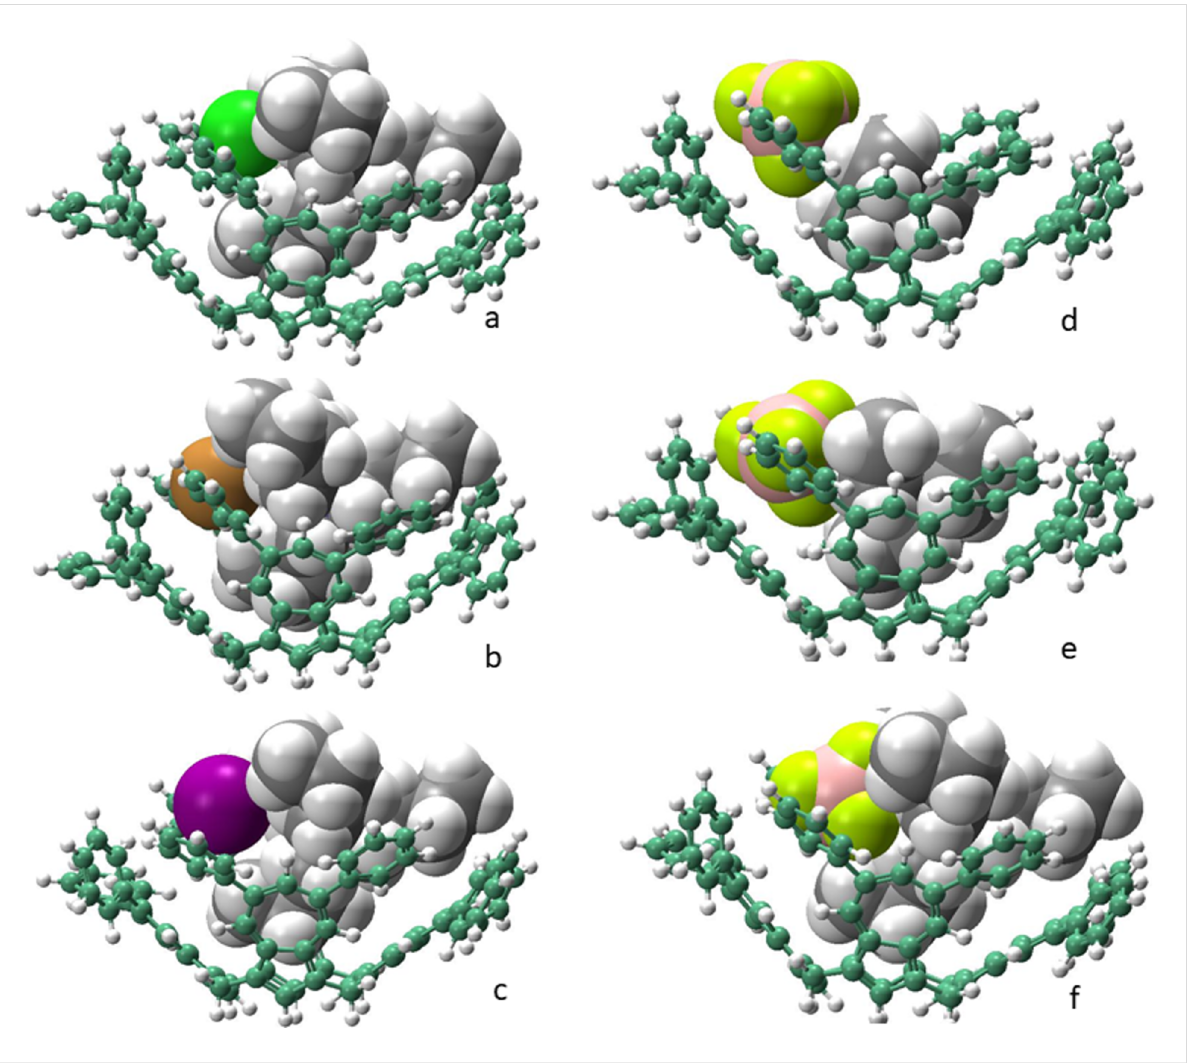
Figure 3: Geometry-optimized ( ω B97xD/6-31G(d)) and ( ω B97xD/GenECP) structures, respectively, computed for left: (a) 5 TBACl; (b) 5 TBABr; and (c) 5 TBAI; right: (d) 5 TMABF 4 ; (e) 5 TEABF 4 ; and (f) 5 TBABF 4 .